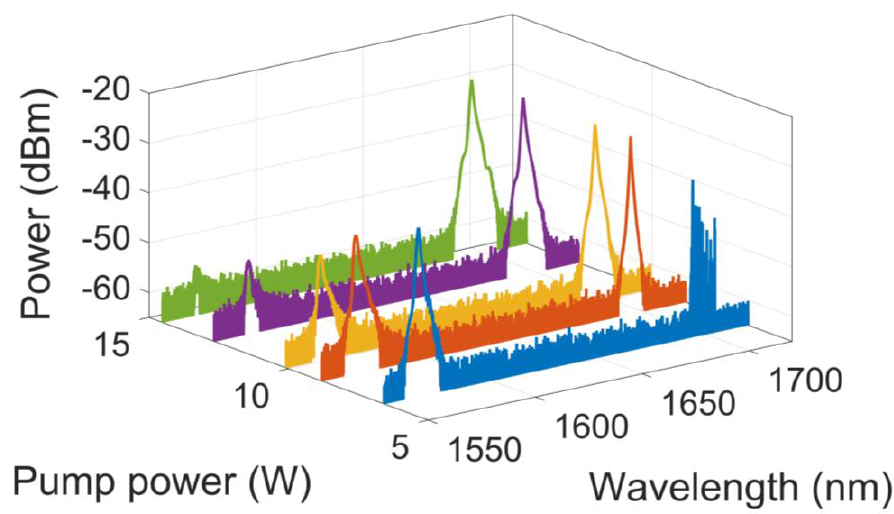
Figure 3. Optical spectra of the 1694 nm RFL at different pump powers of the 1565 RFL.